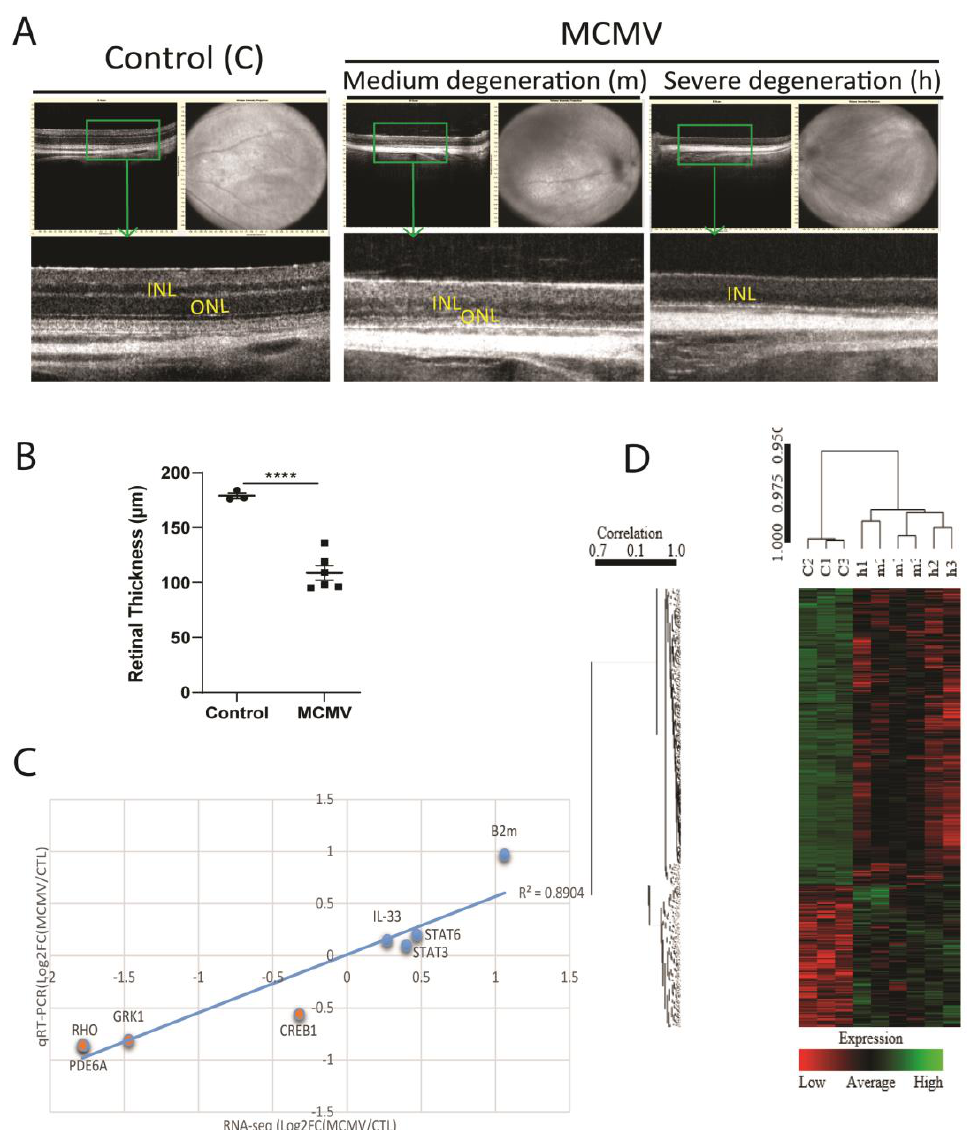
Figure 1. ( A ) Representative images of SD-OCT in eyes of latently infected mice with medium retinal degeneration (m) and severe retinal degeneration (h) at 18 months p.i., together with age-matched control eyes (c). ( B ) Retinal thickness by SD-OCT. **** p < 0.0001 using the Mann-Whitney test. ( C ) Validation of RNA-seq transcriptome data by qRT-PCR analysis of eight genes in three control and six virus-infected samples. ( D ) A Heat map for three control samples (c1, c2, c3) and six virus-infected samples (m1, m2, m3, h1, h2, h3).